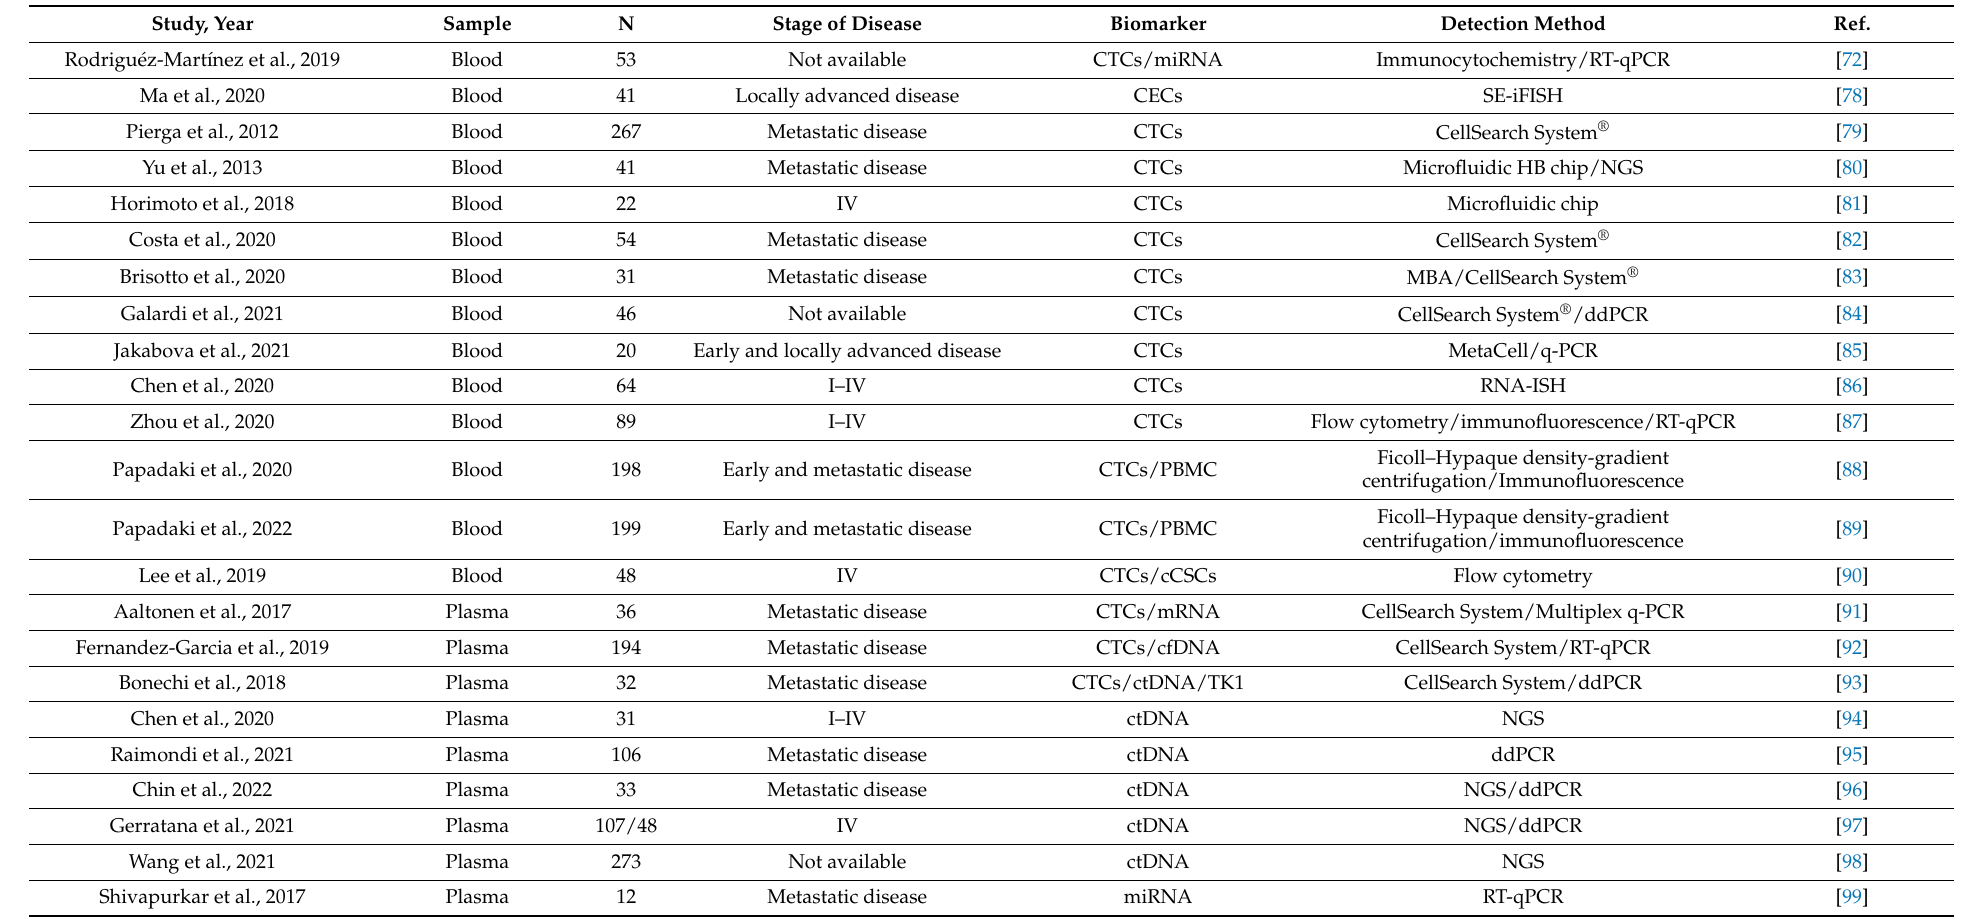
Table 4. Summary of potential non-invasive biomarkers using liquid biopsy for prediction of treatment response and early detection of